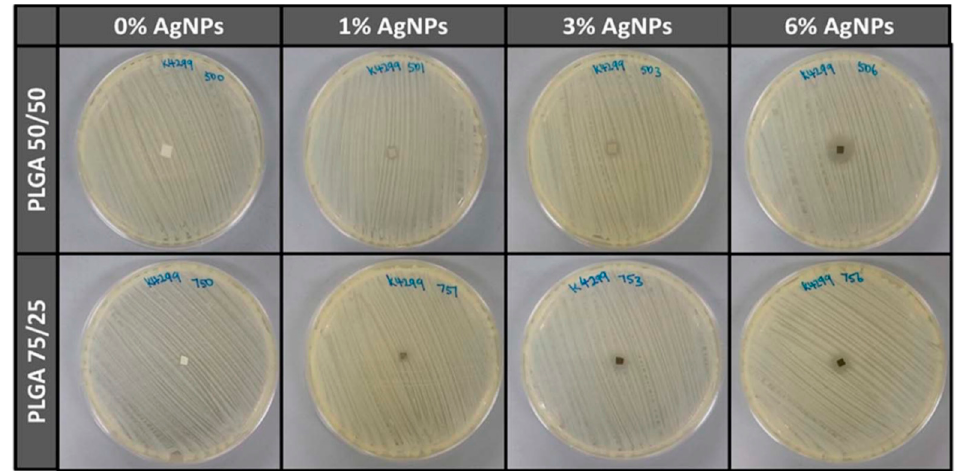
Figure 19. Antibacterial activity of electrospun PLGA 50/50 and PLGA 75/25 mats with and